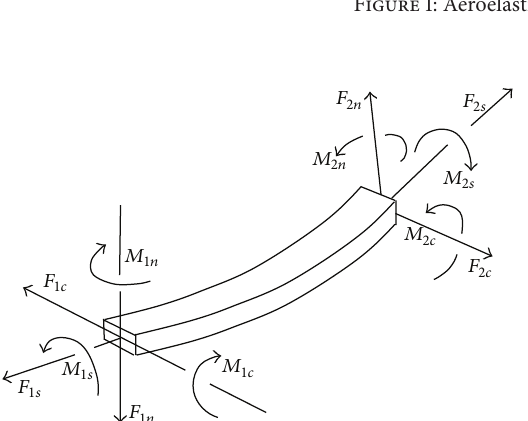
Figure 2: Description for Euler beam